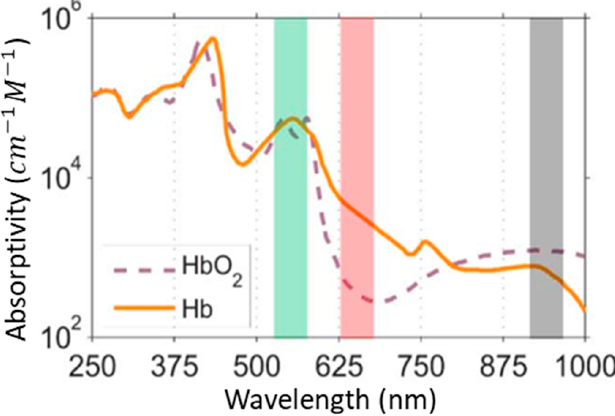
Figure 11. Absorptivities of oxy ‐ hemoglobin (HbO 2 ) and deoxyhemoglobin (Hb) [10].